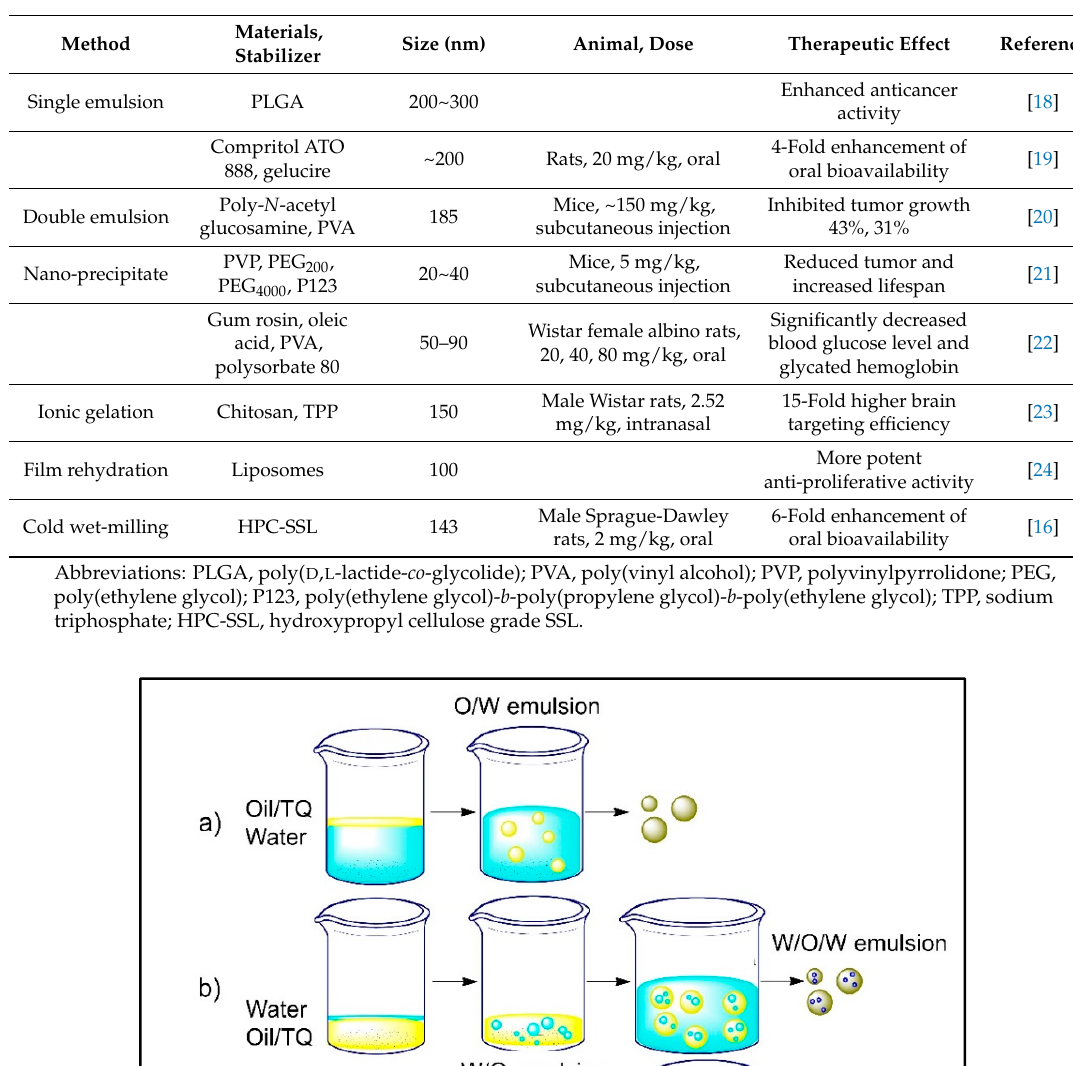
Table 1. TQ and TQ nanoformulations and characteristics.